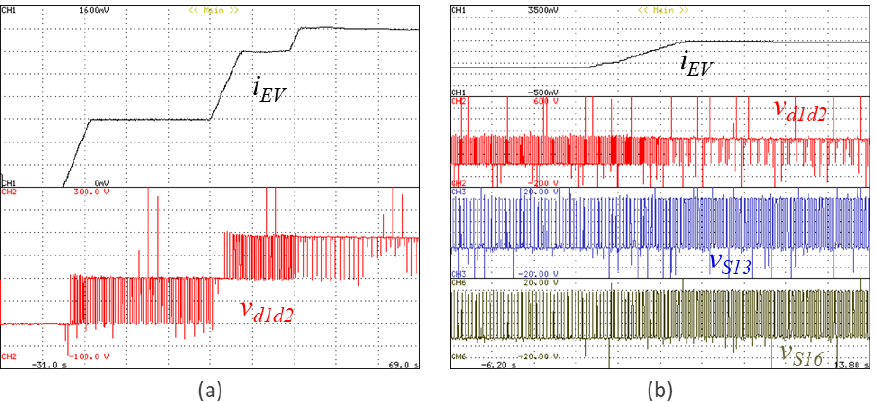
Figure 10. Experimental validation regarding the EV interface with the possibility to operate with three voltage levels, showing the EV current ( i EV ), the voltage of the unified topology ( v d 1 d 2 ) on the DC-side interface with the EV, and the gate-emitter voltages of the IGBTs S 13 and S 16 ( v S 13 , v S 16 ): ( a ) EV current and converter voltage; ( b ) EV current and converter voltage, and the gate-emitter voltages of the IGBTs S 13 and S 16 .